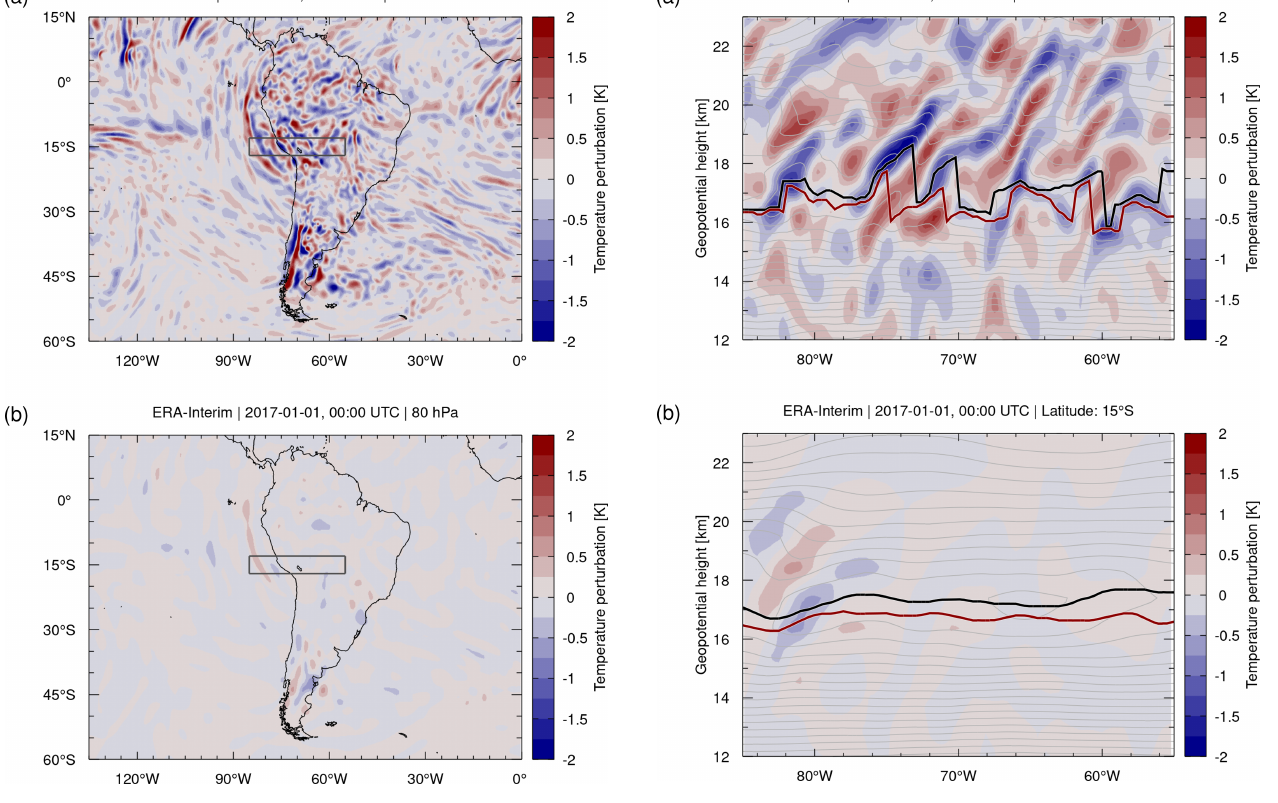
Figure 9. Temperature perturbations (contour surface) derived by means of a horizontal Gaussian high-pass filter applied to (a) ERA5 and (b) ERA-Interim reanalysis data on 1 January 2017, 00:00UTC. Meridional cross sections through the data for the re- gion indicated by the gray box are shown in Fig. 10.